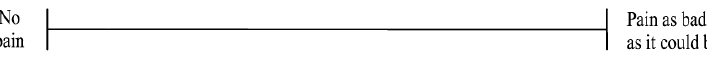
Figure 1. Visual Analogue Scale (VAS).